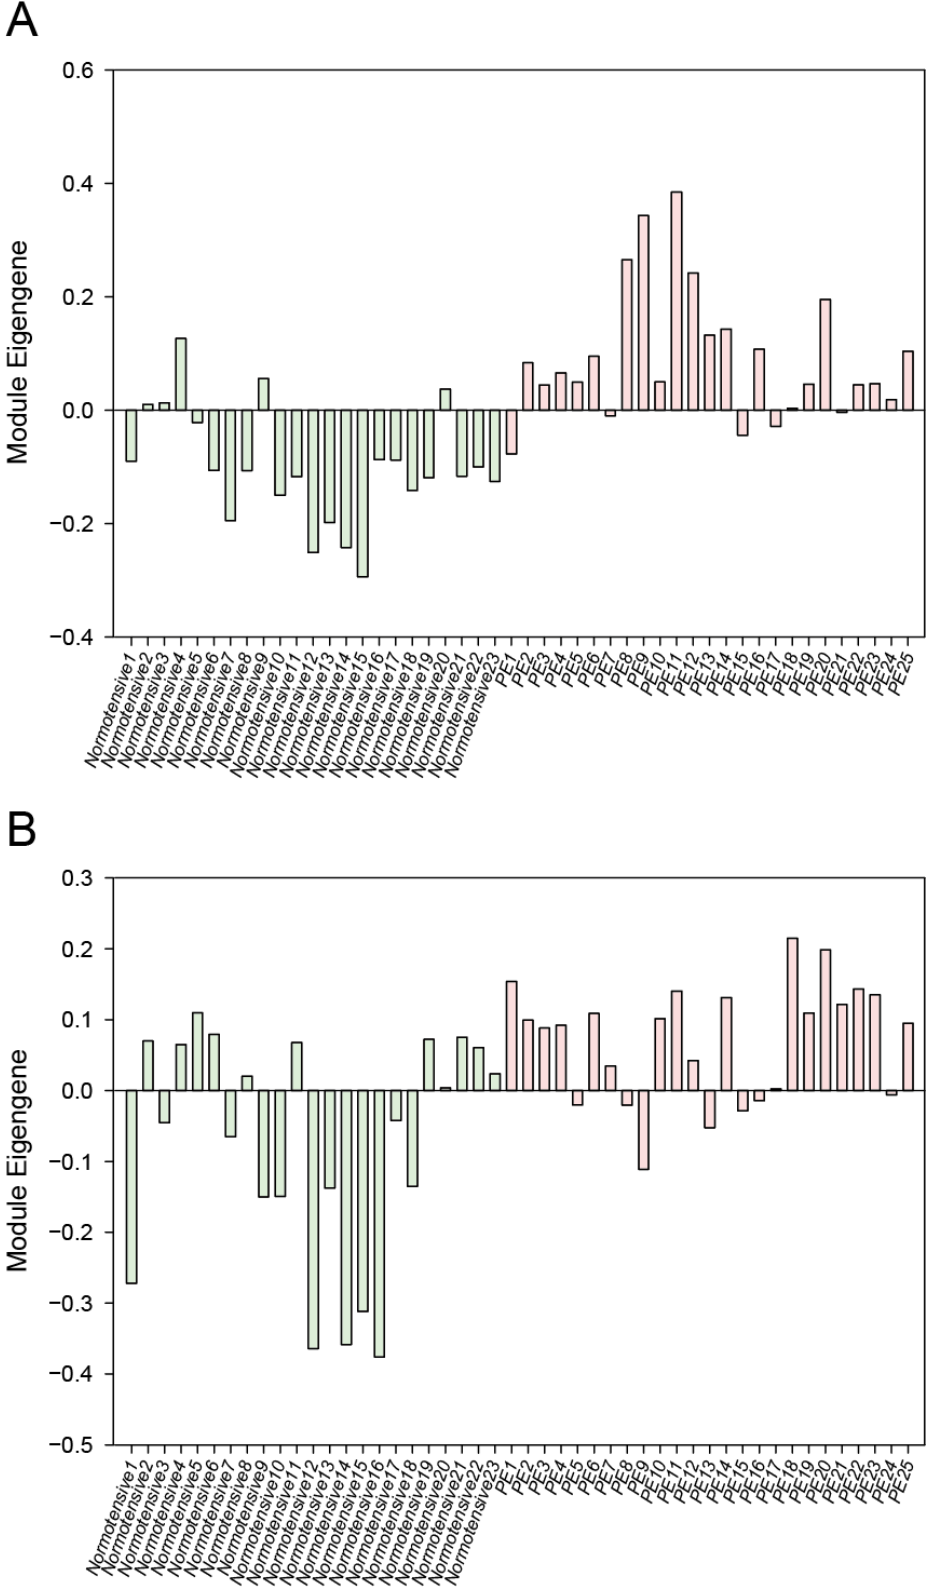
Figure 3. The eigengene expression patterns for the cyan ( A ) and magenta ( B ) modules in the normotensive and PE groups.